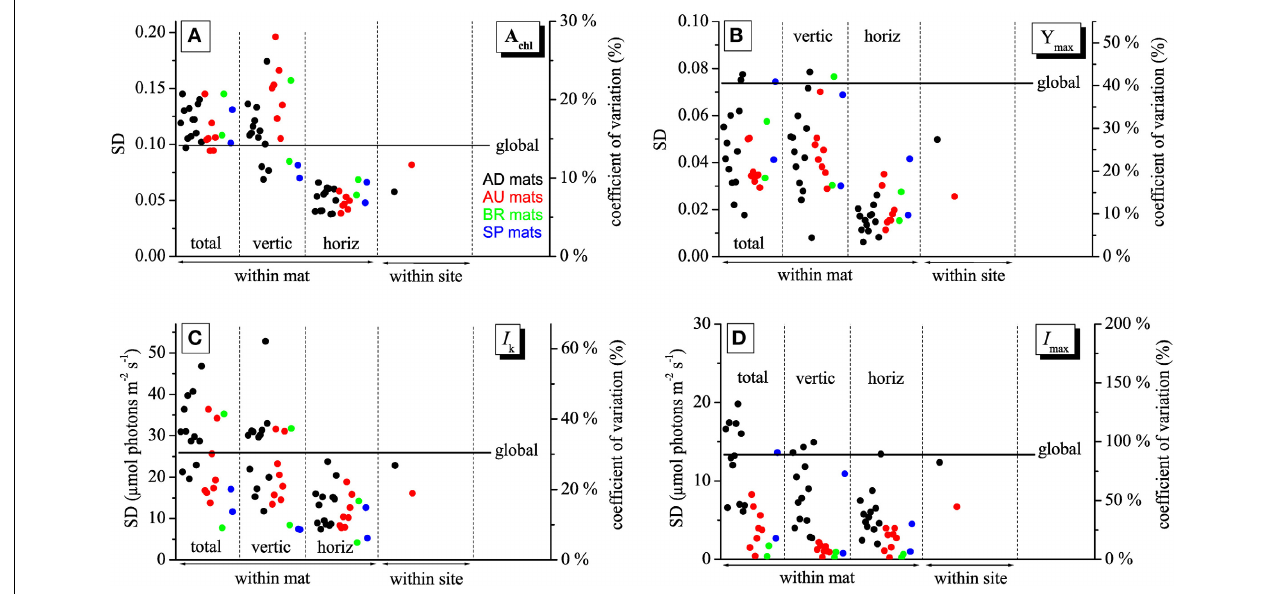
global (between sites) scales. See text for details. The variabilities are expressed as standard deviations, SD (left axis), and as a coefficient of variation (right